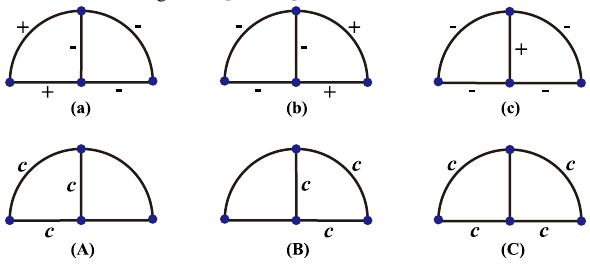
Fig. 5 The sub-diagram surrounded by the small red box on the left is a compressible scalar-scalar-scalar (scalar–vector–vector) loop, and always generates a tree-level three-point vertex H X X 1 , unless X 1 = H and X transforms as ( 1 , 1 , − 1 ) under the SM gauge group, because the local operator H ( x ) H ( x ) X ( x ) (on the right inside the big red box) vanishes automatically due to the anti-symmetric contraction of the two SU ( 2 ) L doublets H to the singlet X , whereas the non-local operator H ( x ) H ( y ) X ( z ) realized at one loop (on the left inside the big red box) does not vanish in general [89,100]